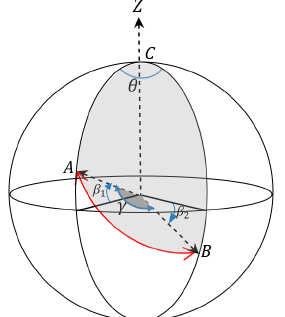
Figure 3. Spherical triangle ABC and oblique angle